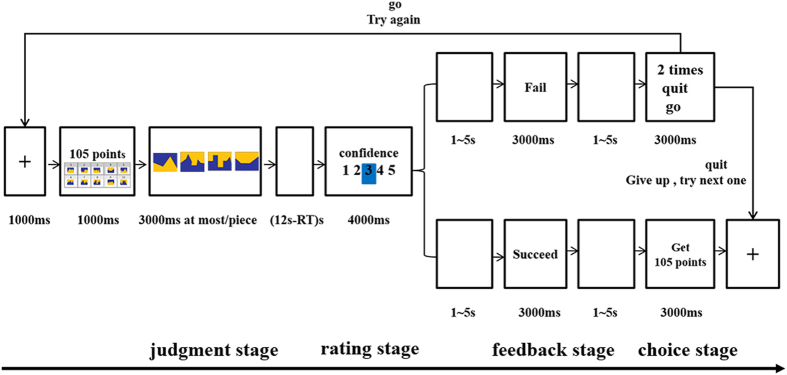
Visual shape discrimination task.Each trial in the task started with, a fixation point displayed in the center of the screen for 1000 ms. Next, ten pictures (each picture was divided into two colored areas) in a specific stimulus set, and the potential reward value, were shown for 1000 ms. Subjects were required to make judgments on which of the two colored areas was larger for four pictures, which were randomly selected from the ten pictures in the stimulus set (judgment stage). For each picture, subjects were given a maximum of 3 s to make their judgment and after the last decision was made the display screen went blank for the remainder of the 12 s. After subjects had made all decisions they gave their confidence level on their accuracy on a scale of 1 to 5 (rating stage – 4s). Subjects were told that if they accurately identified which colored part was larger in at least 3/4 stimuli then they would be informed on the screen after 3s (1–5 s jittered interval) that they had passed, otherwise they would be told that they had failed (feedback stage). After a further 3s interval (1–5s jittered) if the subjects passed they were informed they had gained the points on offer (3s) and then moved on to the start of another stimulus set. If subjects failed they were informed that they had won 0 points and how many times they had failed on that specific stimulus set (number displayed on the top of the screen). Subjects were then given the choice to either try again with the same stimulus set or to quit and try a new one (choice stage).